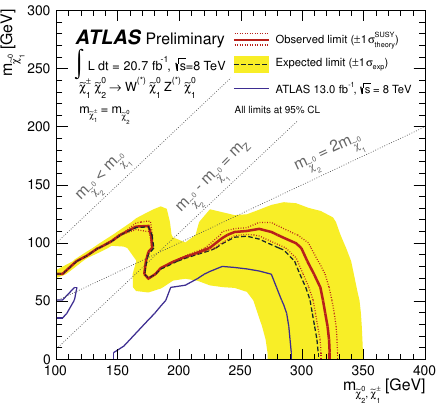
Figure 18: Observed and expected 95% CL limit contours for chargino and neutralino pro- duction in the simplified model scenario with decay via bosons.